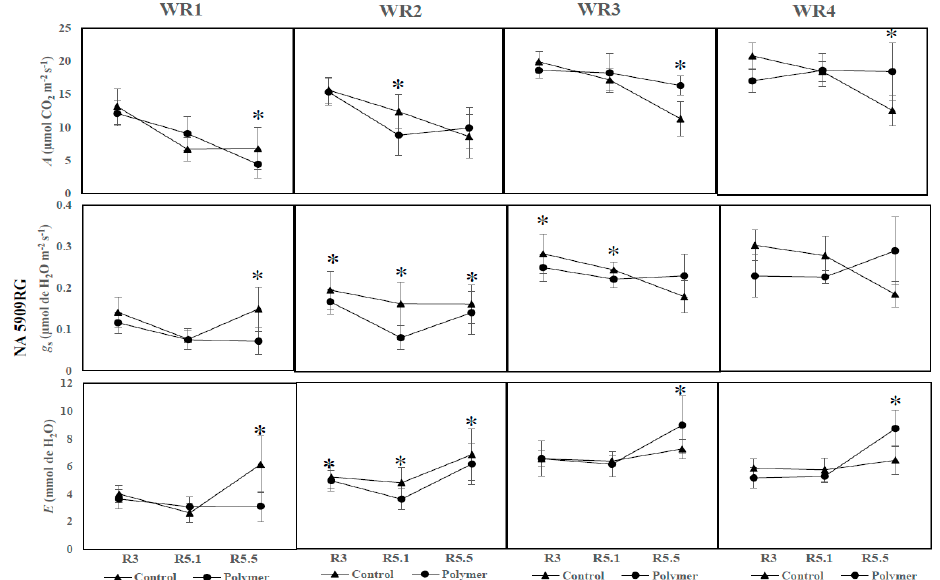
Figure 5. Photosynthesis, ( A ), stomatal conductance ( g s ) and transpiration ( E ) under four water regimes (WR) in three phenological stages of soybean with and without polymer supply (WR1 167 mm, WR2 237 mm, WR3 341 mm, WR4 534 mm) for the NA 5909RG cultivar, in 2017. * indicates significant differences between the control and polymer treatments within each WR and phenological phase by Tukey’s test ( p < 0.05).